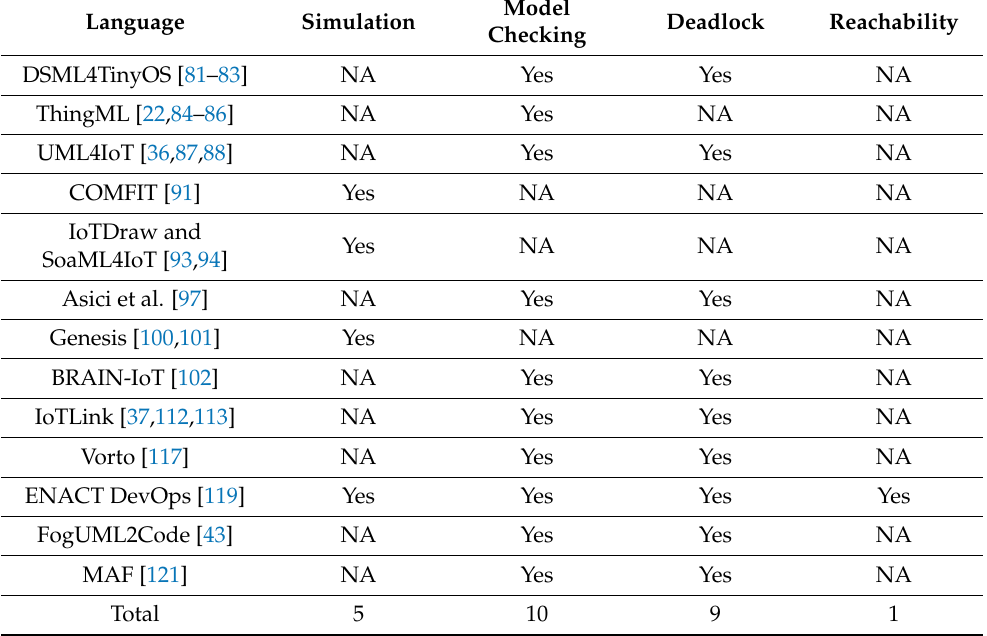
Table 7. The modeling languages for IoT that support the model analysis via some additional capabilities. Language Simulation